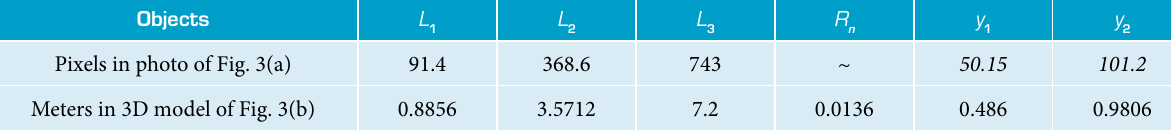
Table 1. The detail parameters of the 3D PRAHV model